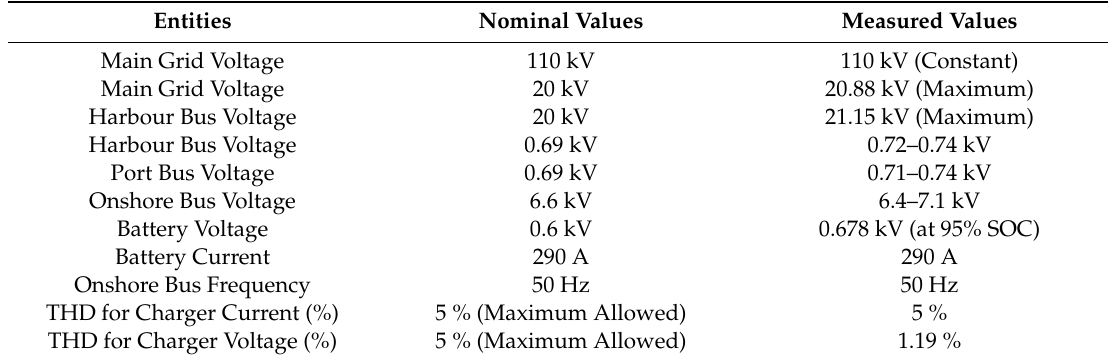
Table 2. Simulation results of Configuration A: Container-based charging of batteries and cold-ironing.